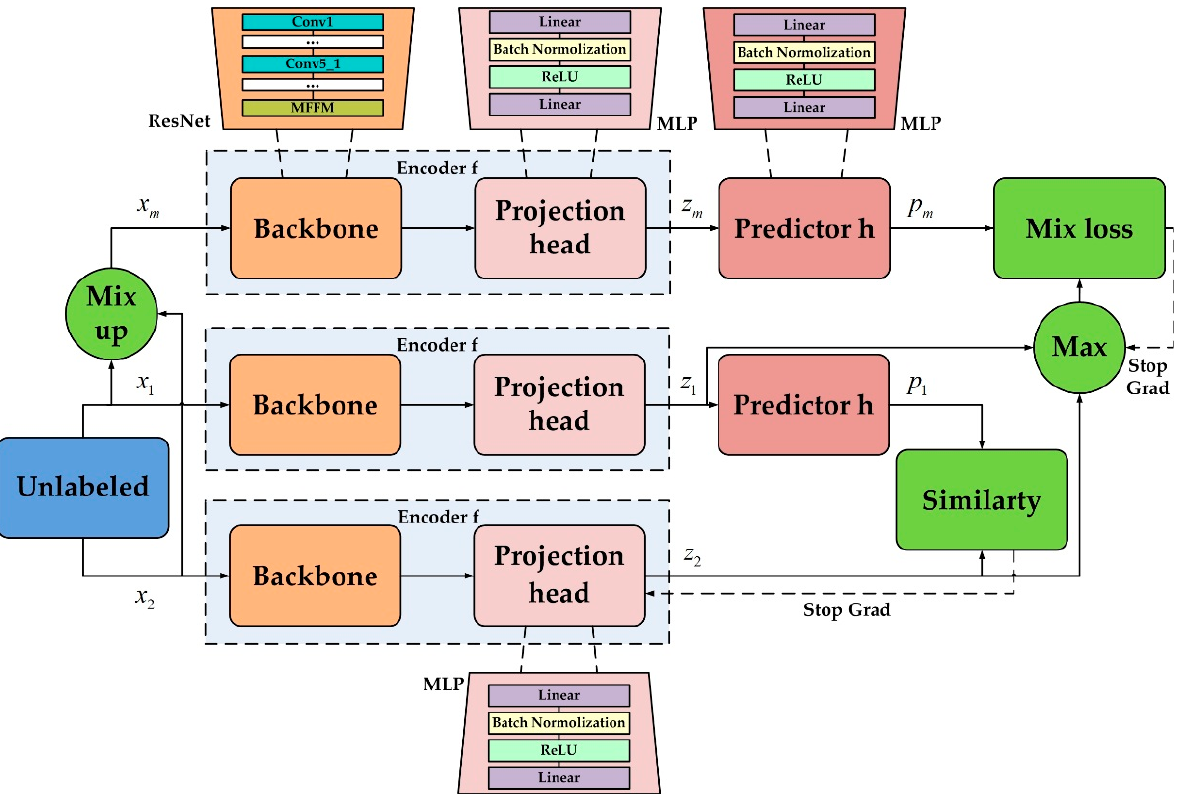
Figure 2. Backbone pre-training framework based on our improved CSSL method.